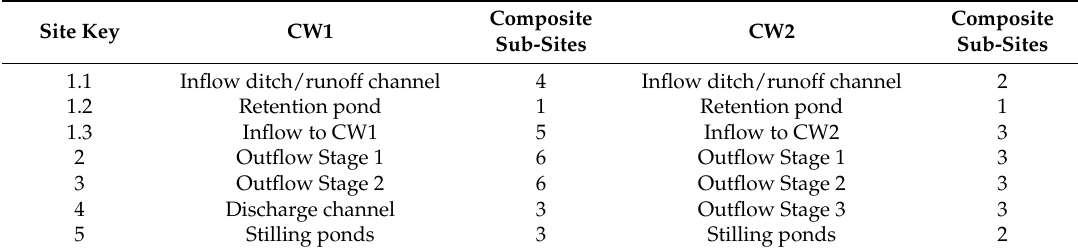
Table 1. Key to site descriptions within constructed wetland (CW) 1 and 2, and number of sub-sampling sites from which water was collected and mixed for composite